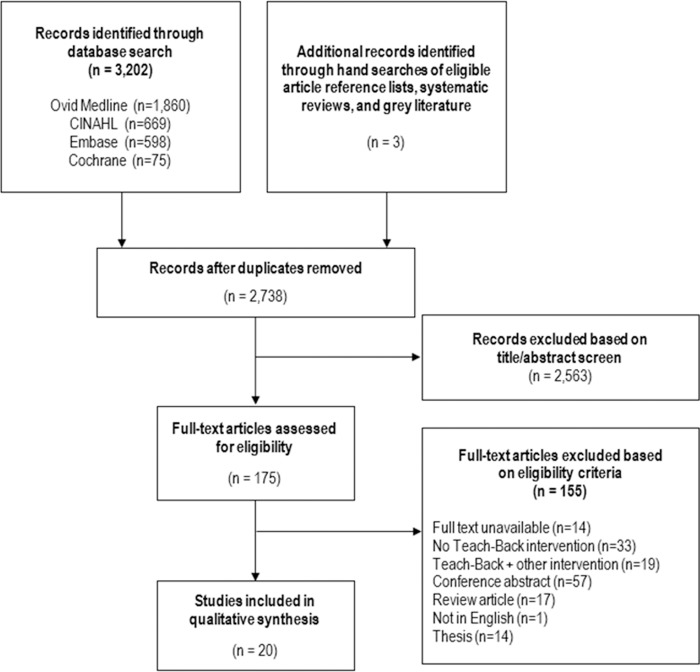
Study selection.